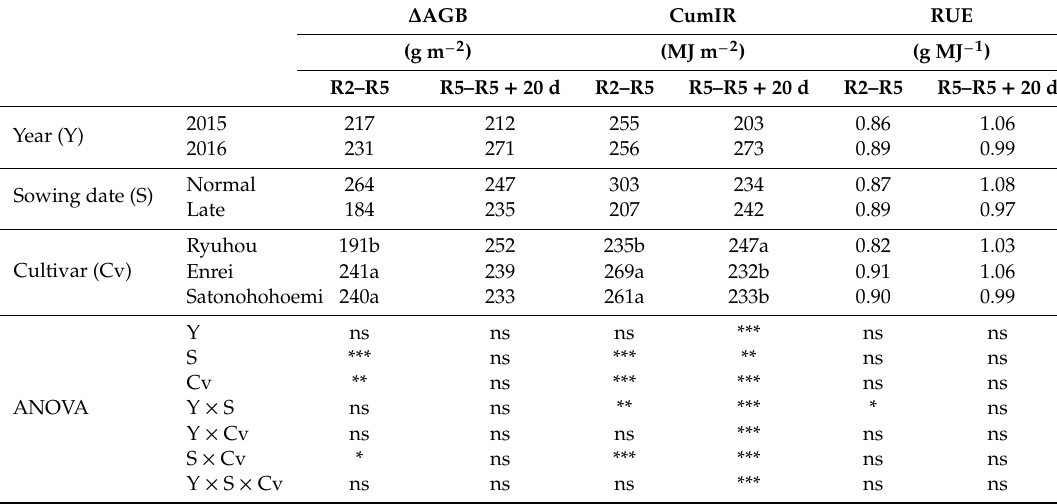
Table 4. Increase in aboveground biomass ( ∆ AGB, g m − 2 ), cumulative intercepted irradiation (CumIR, MJ m − 2 ), and radiation use e ffi ciency for dry matter production (RUE, g MJ − 1 ) during the reproductive stages (from R2 to R5 and from R5 to 20 days after R5) of three soybean cultivars (Ryuhou, Enrei, Satonohohoemi) with normal and late sowing dates in 2015 and 2016 in the Tohoku region of northern Japan. ∆ AGB